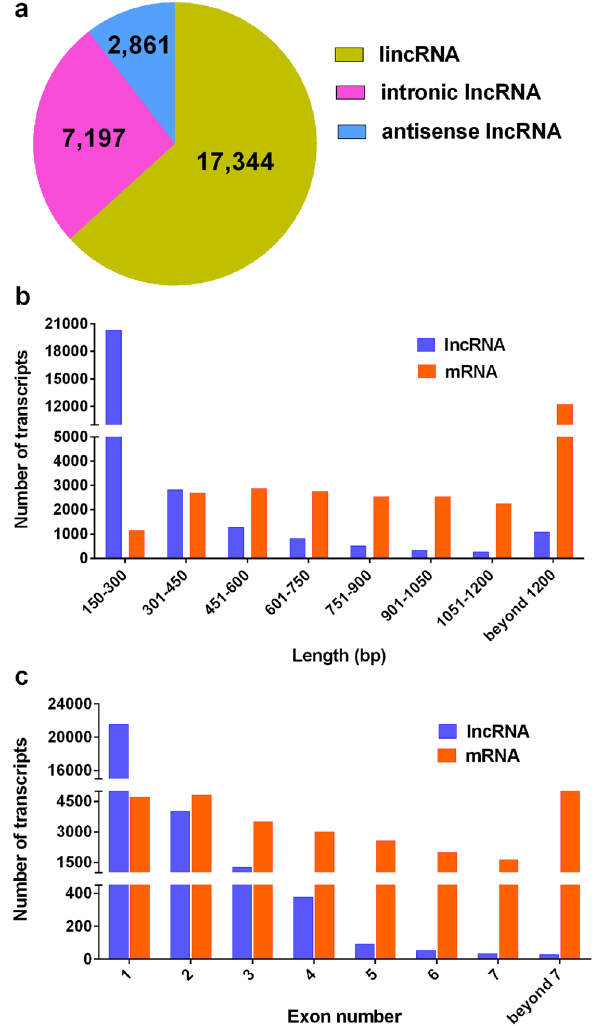
Figure 2. Classification, length distribution, and exon number of lncRNAs and mRNAs in A. deliciosa “Miliang-1”. ( a ) Pie chart of lncRNAs categorized as lincRNAs, intronic lncRNAs, and antisense lncRNAs. ( b ) Length distribution of lncRNAs and mRNAs. ( c ) Exon numbers of lncRNAs and